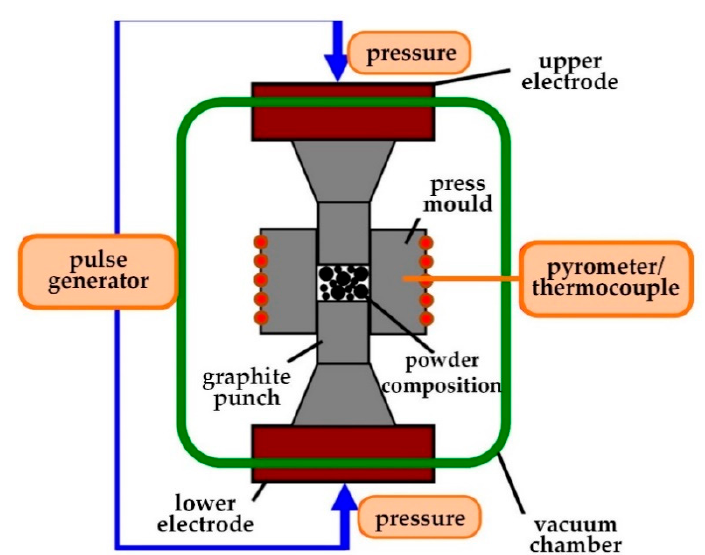
Figure 4. A schematic diagram of the ceramic composition’s spark plasma sintering. Ten disk-shaped samples of 3.0 mm thickness and 20.0 mm diameter were made from